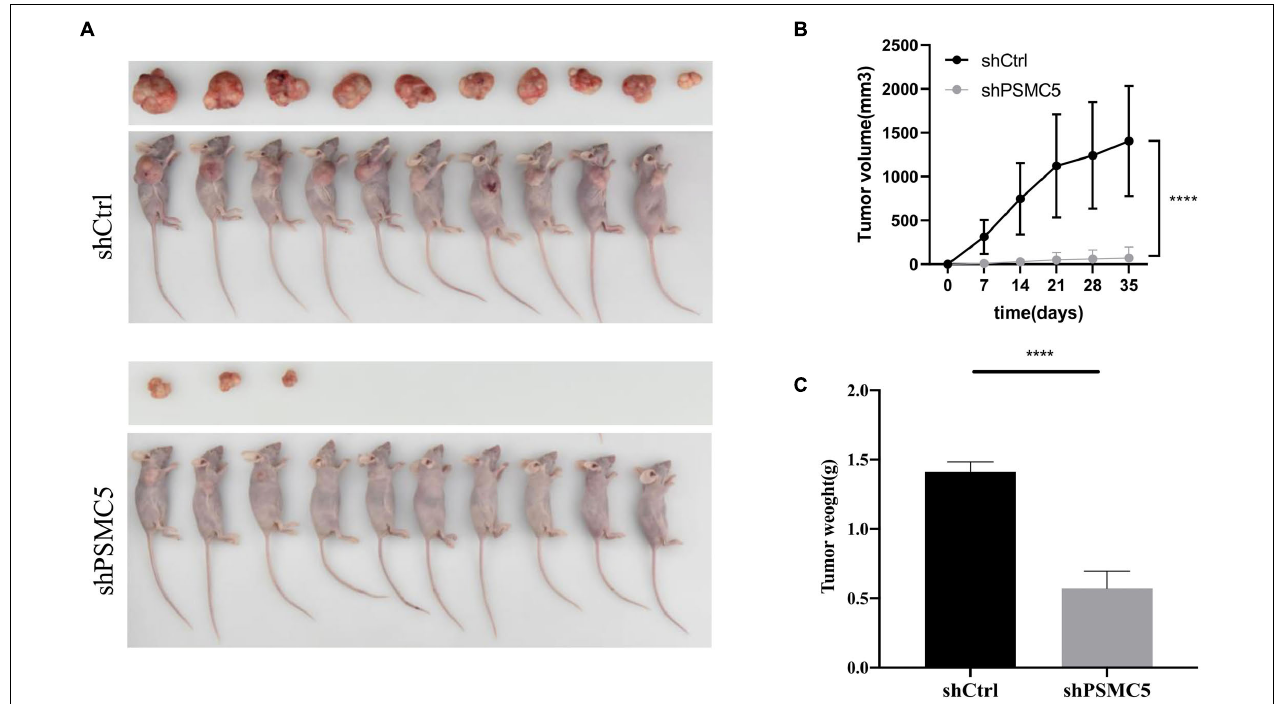
FIGURE 3 | Effects of PSMC5 knockdown on tumor growth in vivo . (A) Images of tumors in nude mice. (B) Tumor volume measured per week in different groups. p values were calculated by one-way ANOVA test. **** p < 0.0001. (C) Tumor weight in shCtrl and shPSMC5 groups. p value was determined by Student’s t -test. **** p <